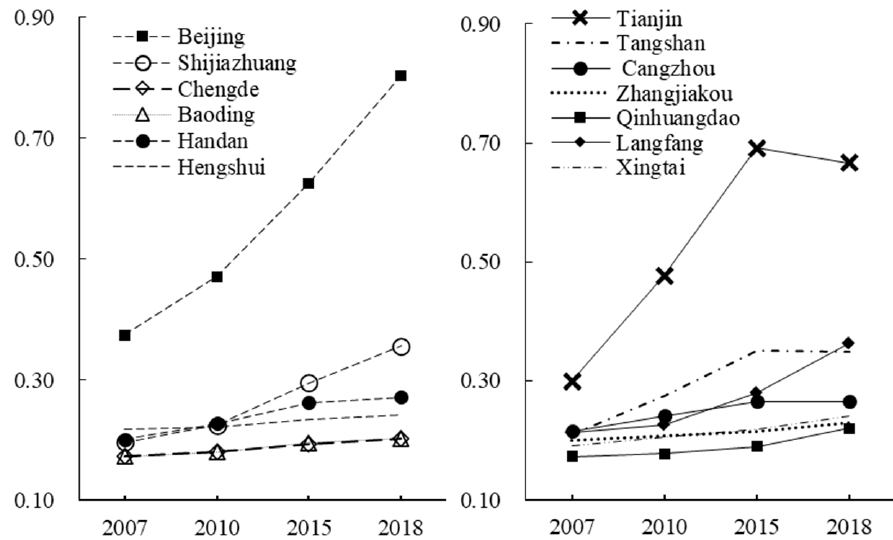
Figure 3. Changes in the LES of the BTH region. Table 4. The LES of BTH region from 2007 to 2018.